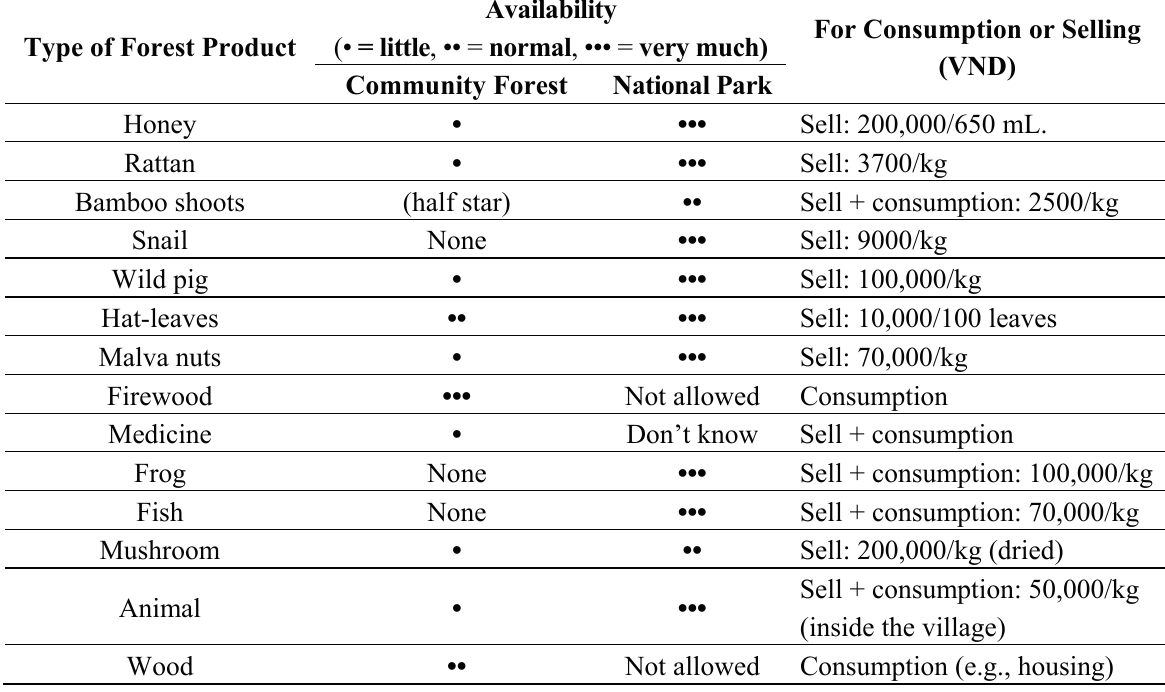
Table 5. Differences between the community forest of village no. 6 and the natural forest in Bach Ma National Park (BMNP). Source: Focus group discussion with households of Village No. 6, Thuong Nhat